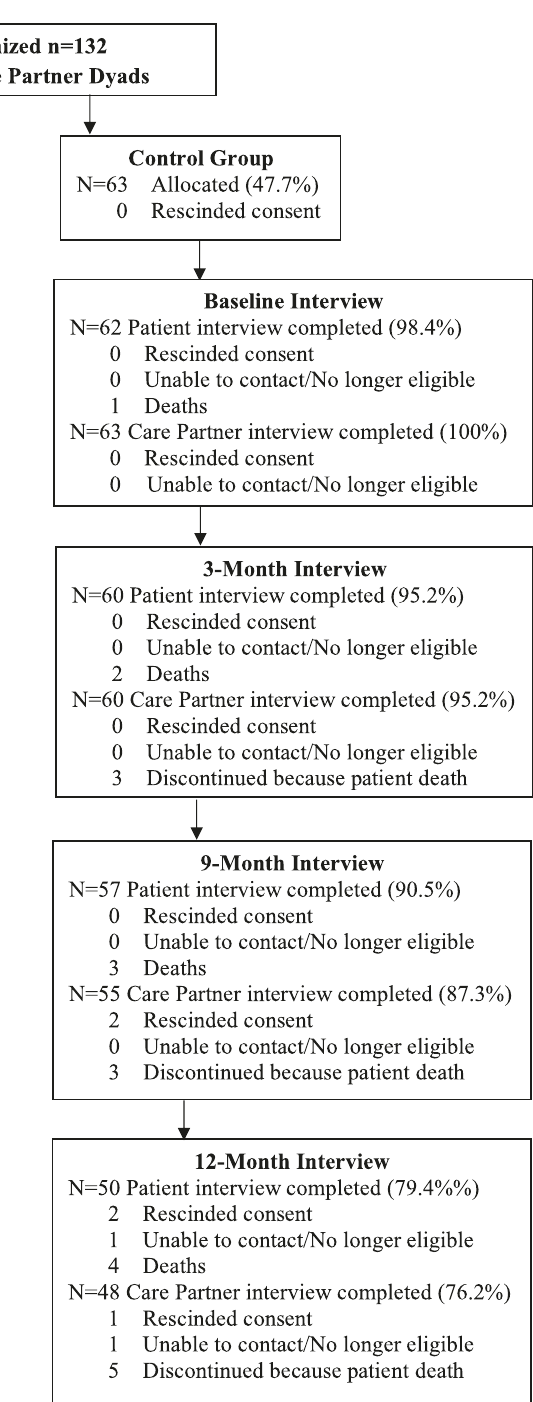
Fig. 1 Participant fl ow. Sharing in care CONSORT